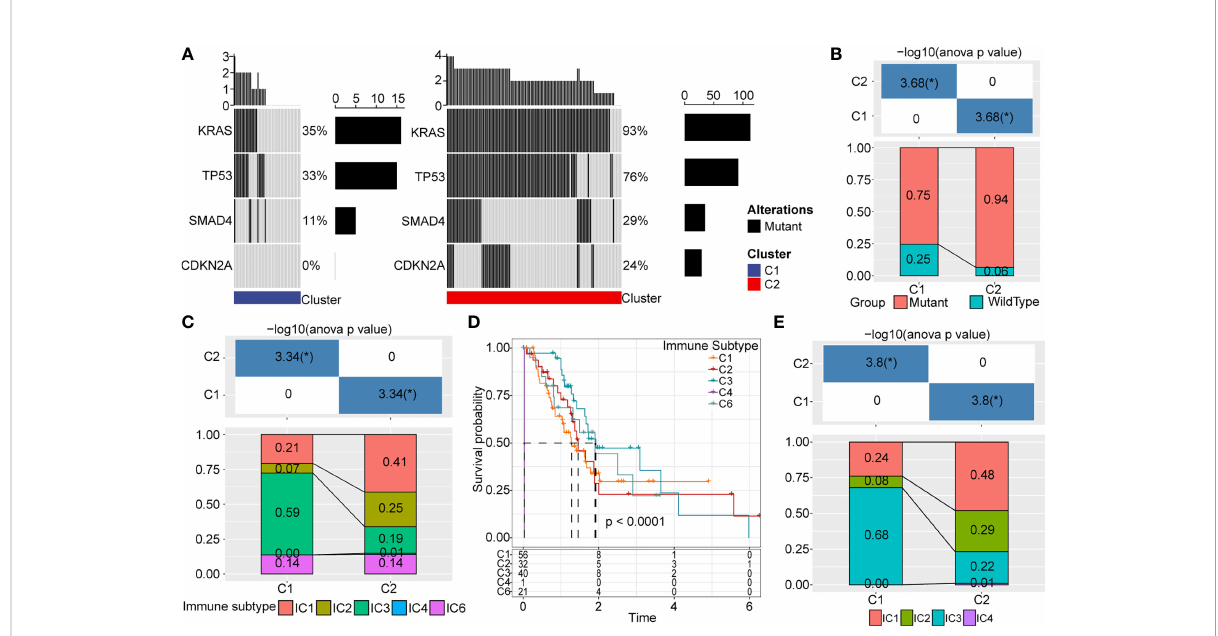
FIGURE 7 Gene mutations and distribution of immune subtypes. (A) Somatic mutations analysis of DEGs in two molecular subtypes. (B) Mutation frequency differences of KRAS among different subtypes in ICGC cohort. (C) Sankey between molecular types and immune subtypes. (D) Survival curve of existing immune subtypes. (E) Distribution of immune subtypes among different molecular types. *p < 0.05.